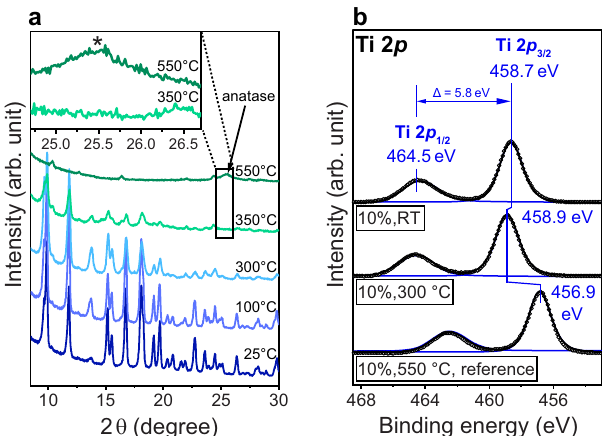
2 (cid:2)(cid:3)(cid:2) (degree) Fig. 2 Characterization of 10%NH 2 -MIL upon heat treatment. a In situ XRD patterns collected during heating in air (0.5 mL min − 1 ) up to 550°C (5 °C min − 1 ). b XPS Ti 2p spectra of as-prepared 10%NH 2 -MIL, and after heat treatments in air at 300 °C and 550 °C (5 h). The shift in binding energies at 550 °C indicates the transformation of the MOF structure into TiO 2 , which correlates well with the appearance of the diffraction at 25.4° (asterisk) characteristic of anatase (inset of Fig. 2a). XRD and XPS of other MOF samples can be found in Supplementary Figs. 5 –